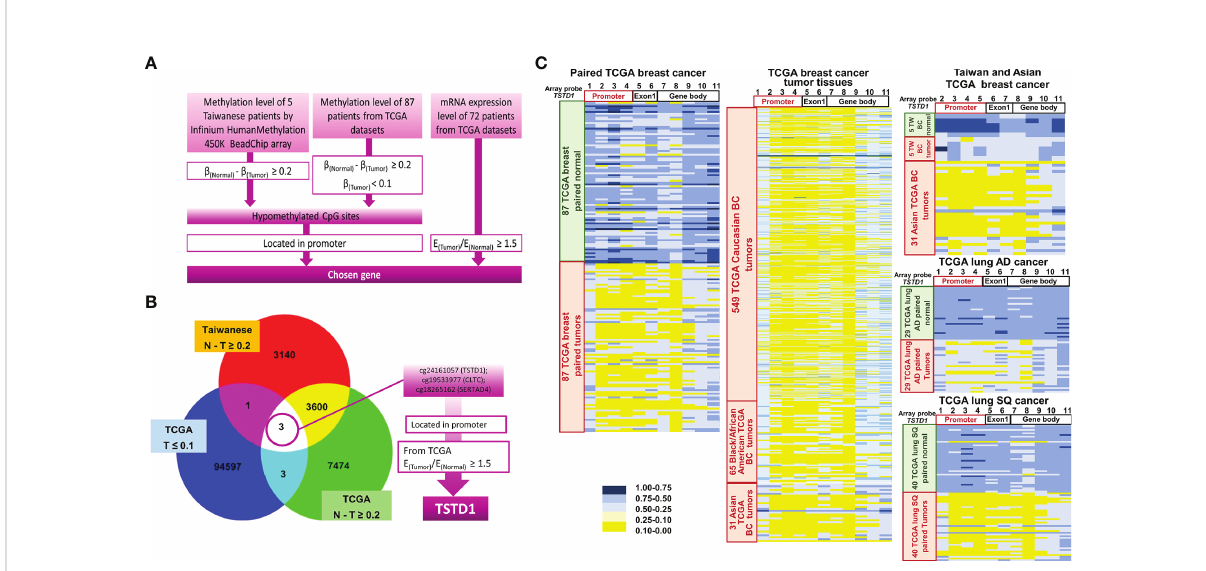
FIGURE 1 Flowchart of gene selection, analytical procedures and methylation heatmap for TSTD1 . (A) The criteria and step-by-step fl owchart for gene selection. (B) Screening of intersecting genes by InteractiVenn. (C) TSTD1 methylation pattern in 87 paired TCGA breast cancer, 549 Caucasian, 65 Black/African and 31 Asian TCGA breast tumor tissues, TSTD1 methylation level of 5 Taiwanese patients, TCGA paired lung adenocarcinoma and paired lung squamous-cell carcinoma by Methylation Beadchips array and EPIC Methylation Beadchips